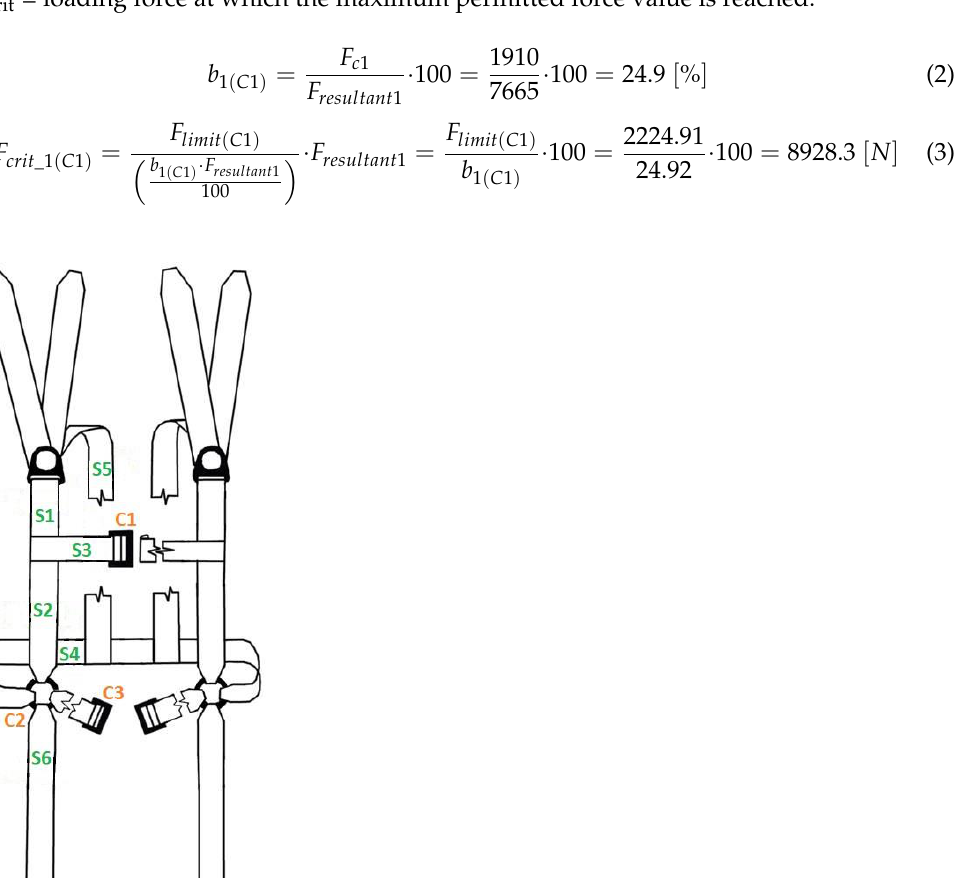
Table 2. Declared strength of the elements.